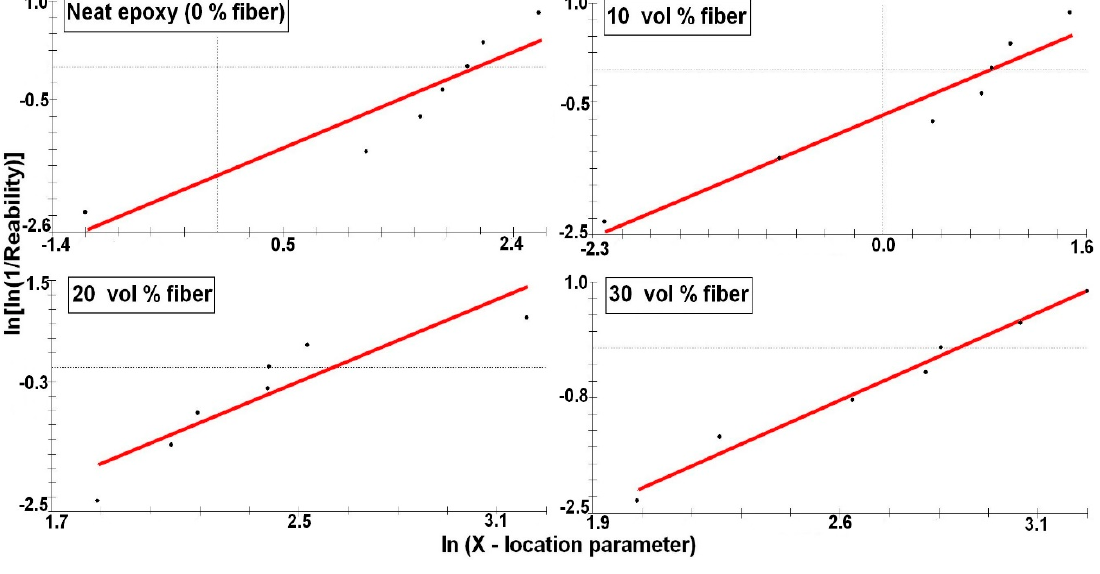
Figure 10. Tensile toughness Weibull plots for the epoxy composites reinforced with different volume fractions of caranan fiber. fractions of caranan fiber. Table 3. Weibull parameters for the measured properties by the tensile strength test of epoxy composites reinforced with caranan fiber Weibull